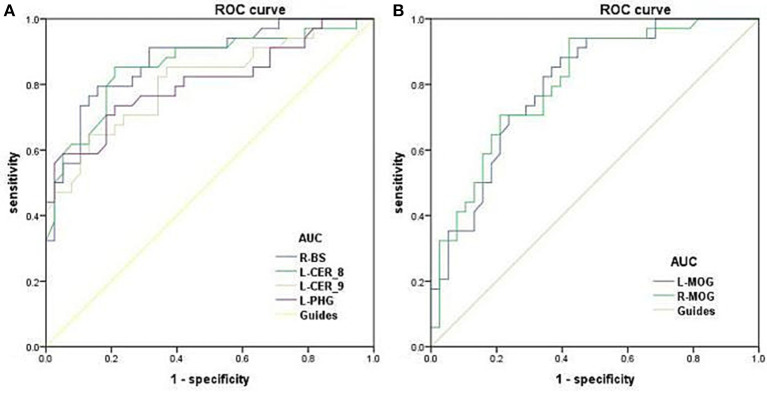
ROC curve analysis of the mean dALFF for altered brain regions. ROC curve in dALFF values: DR>HC, for R-BS 0.874 (P < 0.001; 95% CI: 0.794–0.955); for L-CER_8 0.859 (P < 0.001; 95% CI: 0.769–0.948); for L-CER_9 0.809 (P < 0.001; 95% CI: 0.708–0.910); for L-PHG 0.806 (P < 0.001; 95% CI: 0.701–0.910); (A) DR<HC, for L-MOG 0.800 (P < 0.001; 95% CI: 0.699–0.901); for R-MOG 0.803 (P < 0.001; 95% CI: 0.702–0.904); (B). ROC, receiver operating characteristic; dALFF, dynamic amplitude of low-frequency fluctuation; AUC, area under the curve; BS, Brainstem; CER, Cerebelum; PHG, Parahippocampal; MOG, middle occipital gyrus; L, left; R, right.